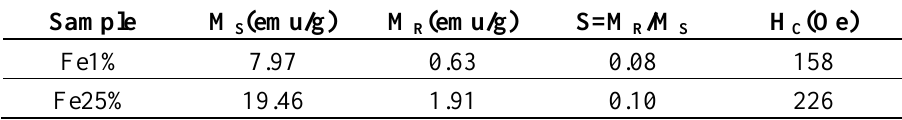
Table 1. Relevant data obtained by magnetization analysis of Fe1% and